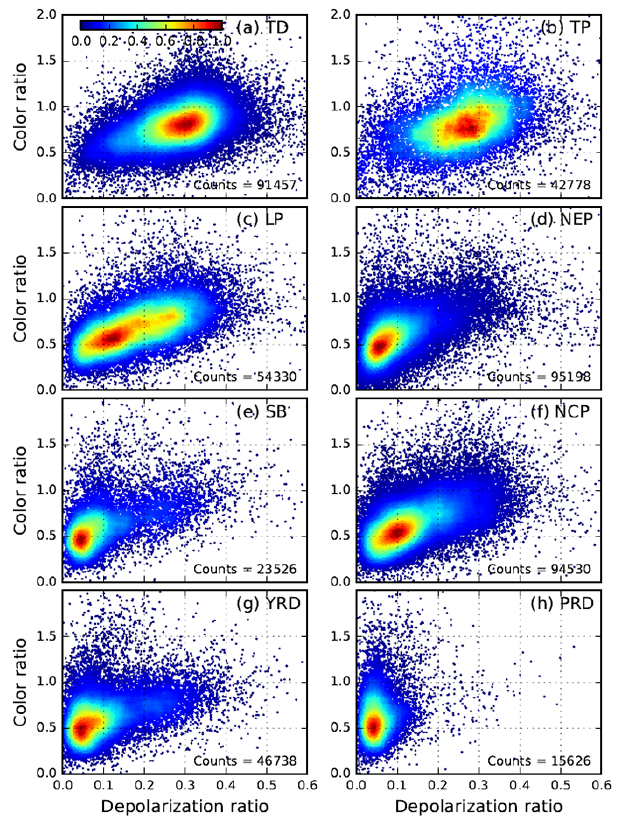
Figure 4. Scatterplots of the layer-integrated aerosol color ratios versus the layer-integrated aerosol depolarization ratios for the fol- lowing regions: (a) Taklamakan Desert (TD); (b) Tibetan Plateau (TP); (c) Loess Plateau (LP); (d) Northeast China Plain (NEP); (e) Sichuan Basin (SB); (f) North China Plain (NCP); (g) Yangtze River Delta (YRD); and (h) Pearl River Delta (PRD).